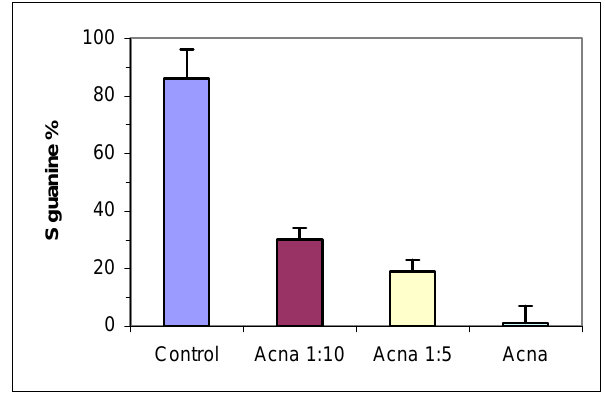
Figure 8. DNA biosensor results for different mixture of a soil from hill n°5 in ACNA area with a control soil (sampling of 2004). Extraction with milli-Q water performed by DISAV. Electrochemical experimental conditions as in Figure 2. Table 6. Comparison of biosensor results performed on ACNA samples (2004 sampling) with other bio-assays for toxicity and stress syndrome detection (results presented at “3° Residential National School of Contaminated Sites”, Alessandria (Italy, 20 th – 22 nd December 2004)).